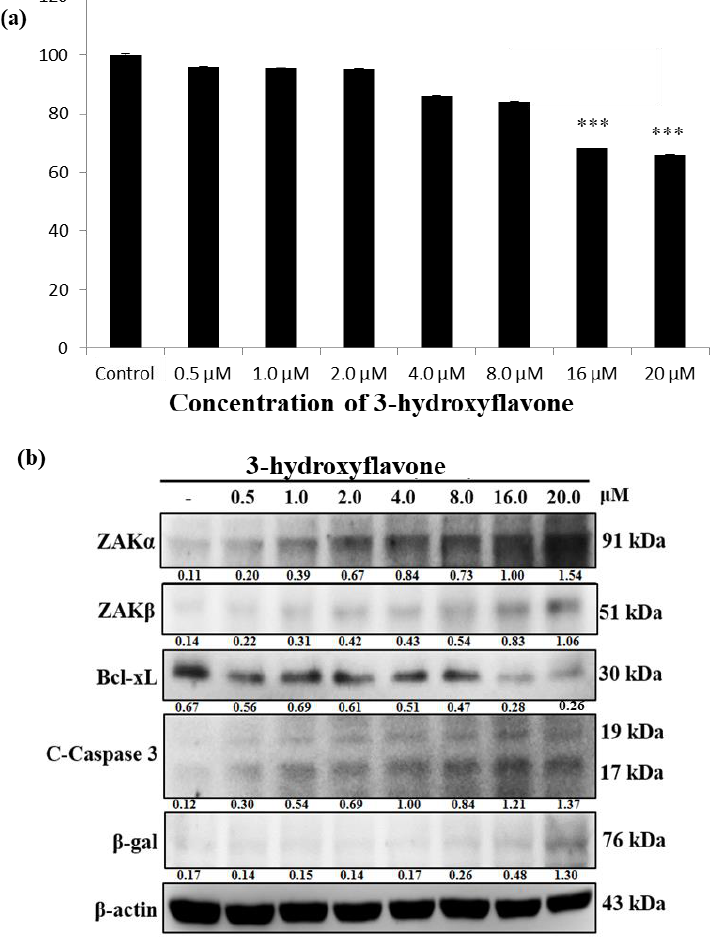
Figure 1. Dose-dependent e ff ect of 3-Hydroxy-2-phenylchromone (3-HF) on human osteosarcoma (HOS) cells. ( a ) E ff ect of 3-HF treatment, which in a dose-dependent manner (0.5–20 µ M) decreased the viability of human OS cells, measured with MTT assays. Data are shown as the mean ± SEM of three independent experiments. ( b ) Western blot analysis of the expression of Zipper sterile-alpha-motif kinase (ZAK), apoptotic protein C-Caspase 3, survival protein Bcl-xL and β -gal with 3-HF treatment in a dose-dependent manner (0.5–20 µ M). *** p < 0.001 represents significance with respect to the control group.